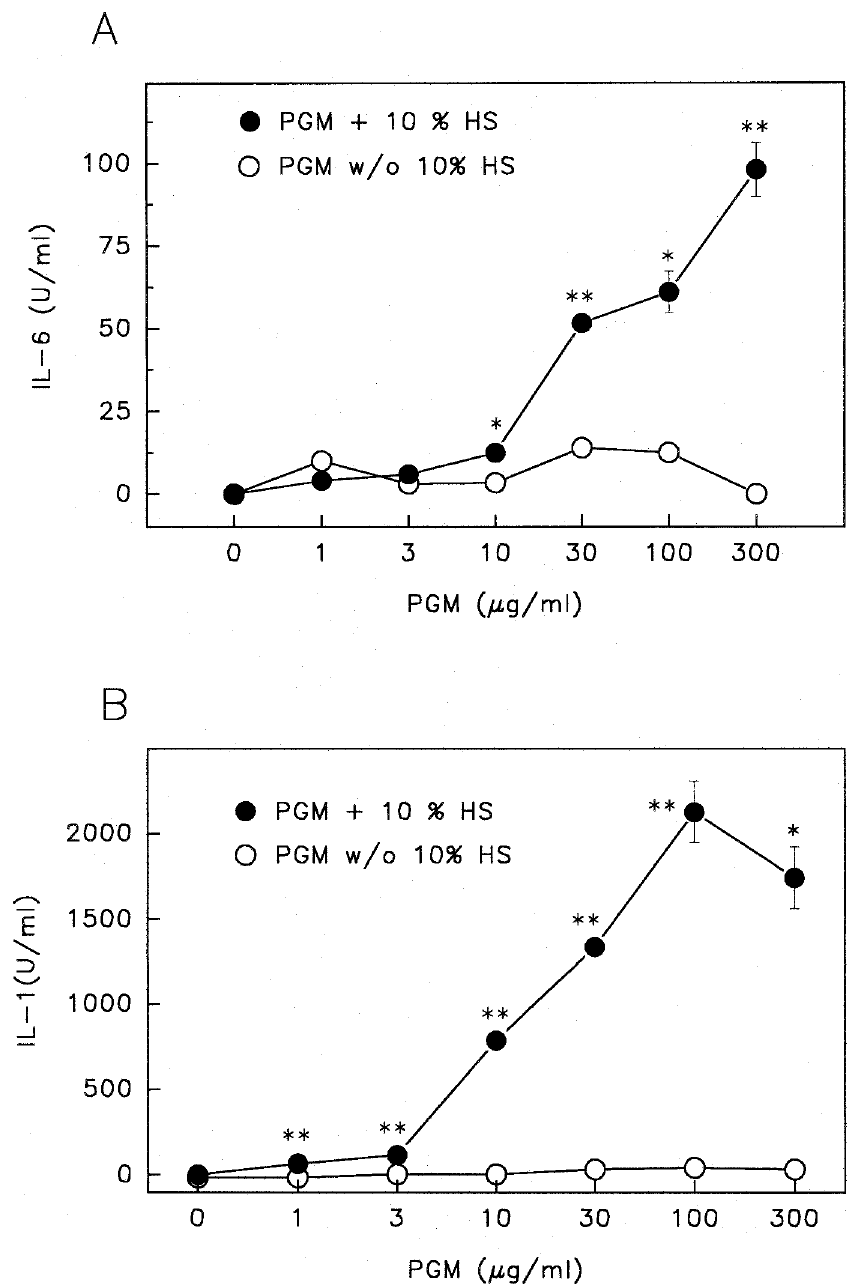
FIG. 1. Induction of IL-6 and IL-1 release from mononuclear cells (MNC) by peptidoglycan monomer (PGM) in the presence or absence of human serum (HS). MNC (4 ´ 10 6 /ml) were stimulated with increasing concentrations of PGM in the presence or absence of 10% HS for 8h. The supernatants were harvested, and (A) IL-6 or (B) IL-1 were measured in bioassays. The data represent the mean of triplicates ± SEM from one of three identical experiments. * p < 0.05, ** p < 0.01, PGM + 10% HS versus PGM without (w/o) 10%